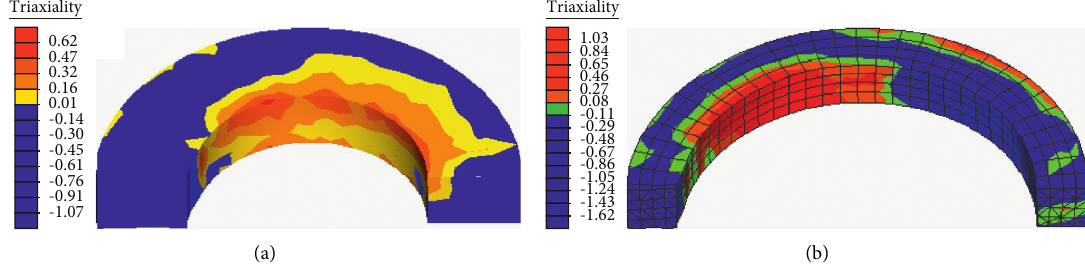
Figure 13: Stress triaxiality distribution in hot ring rolling. (a) In the middle. (b) At the end of the process.